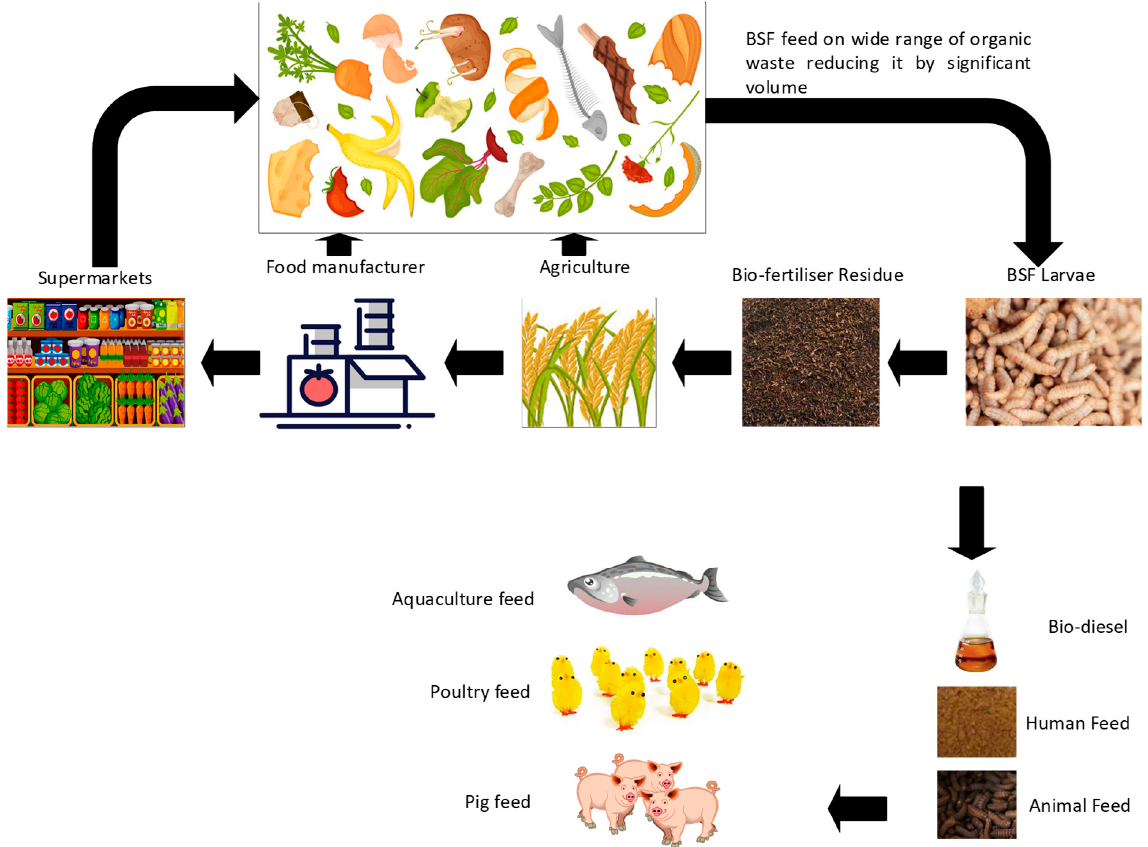
Figure 3. A schematic of BSFL circular economy utilising food manufacturing waste .